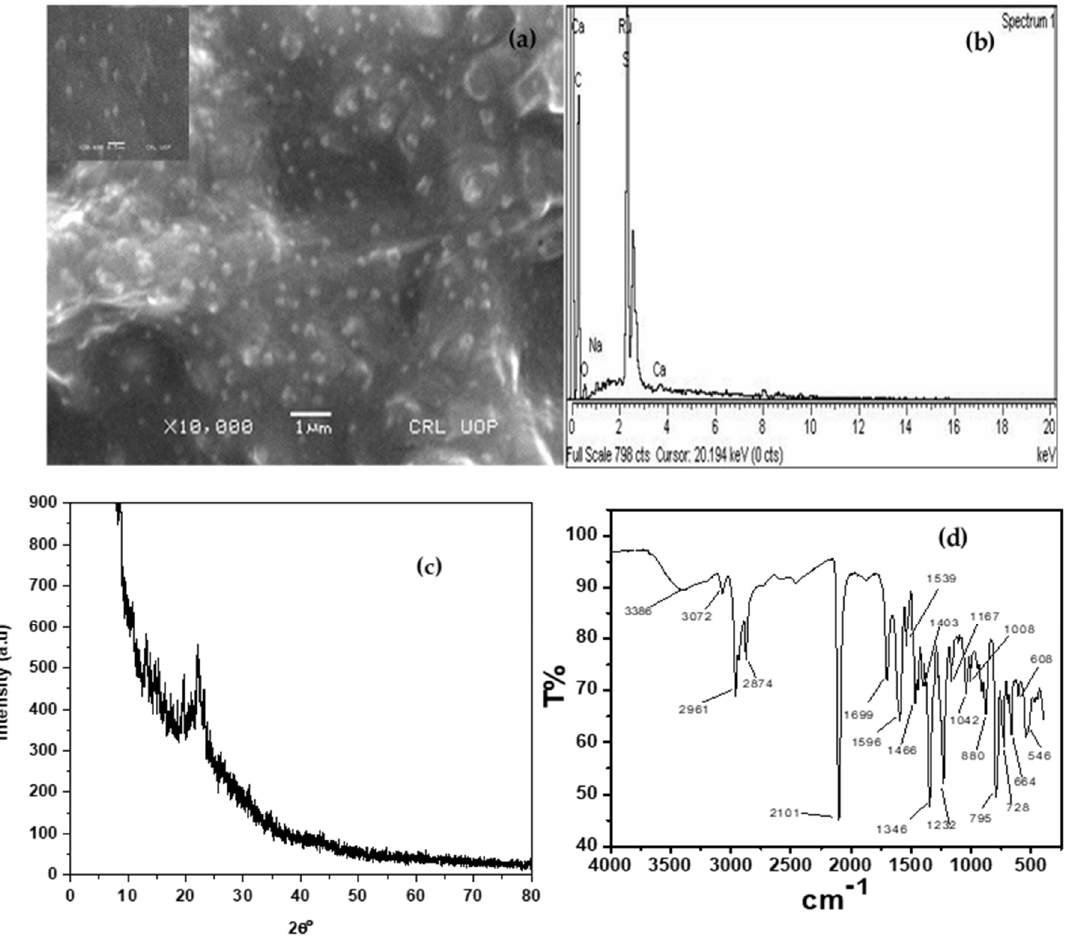
Figure 2. ( a ) SEM micrographs; ( b ) EDX spectrum; ( c ) XRD pattern and ( d ) FTIR transmission spectrum of N749-BD thin film. Table 2. Bond dynamics in N749-BD film.